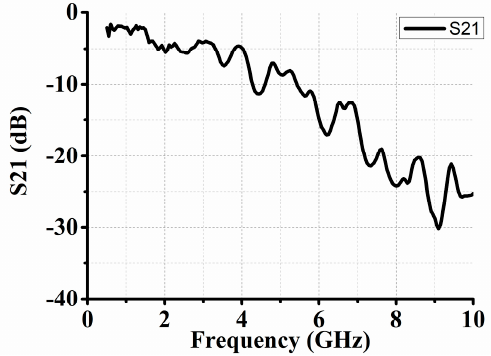
Figure 11. The frequency response of the 22-inch FR4 channel.